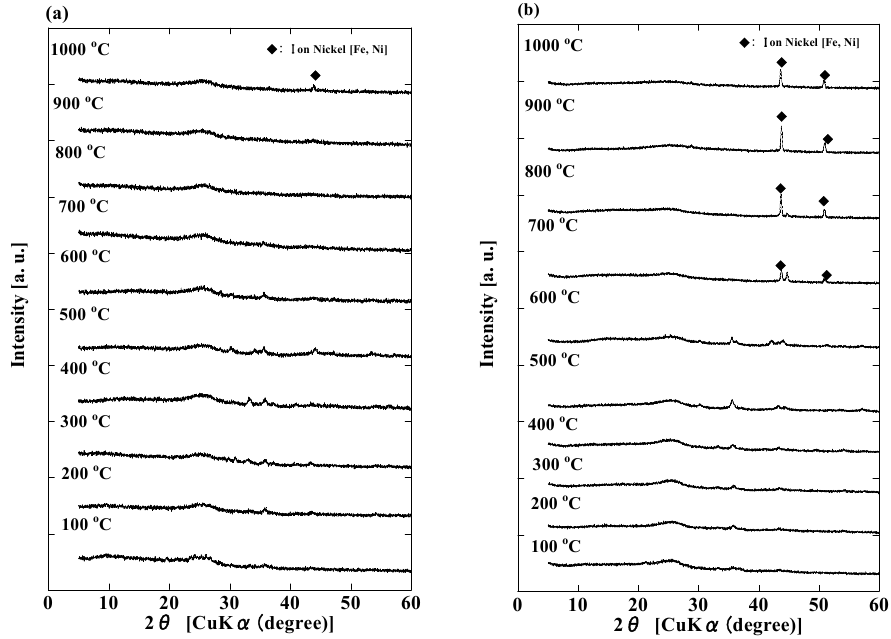
Figure 4. XRD patterns of ( a ) Product-K 2 S and ( b ) Product-KOH after pyrolysis at various temperatures.